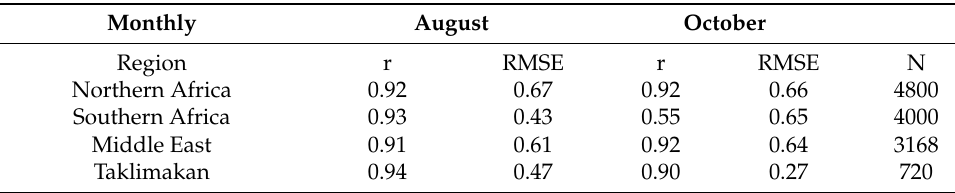
Table 2. Summary of statistical information for the selected stations.